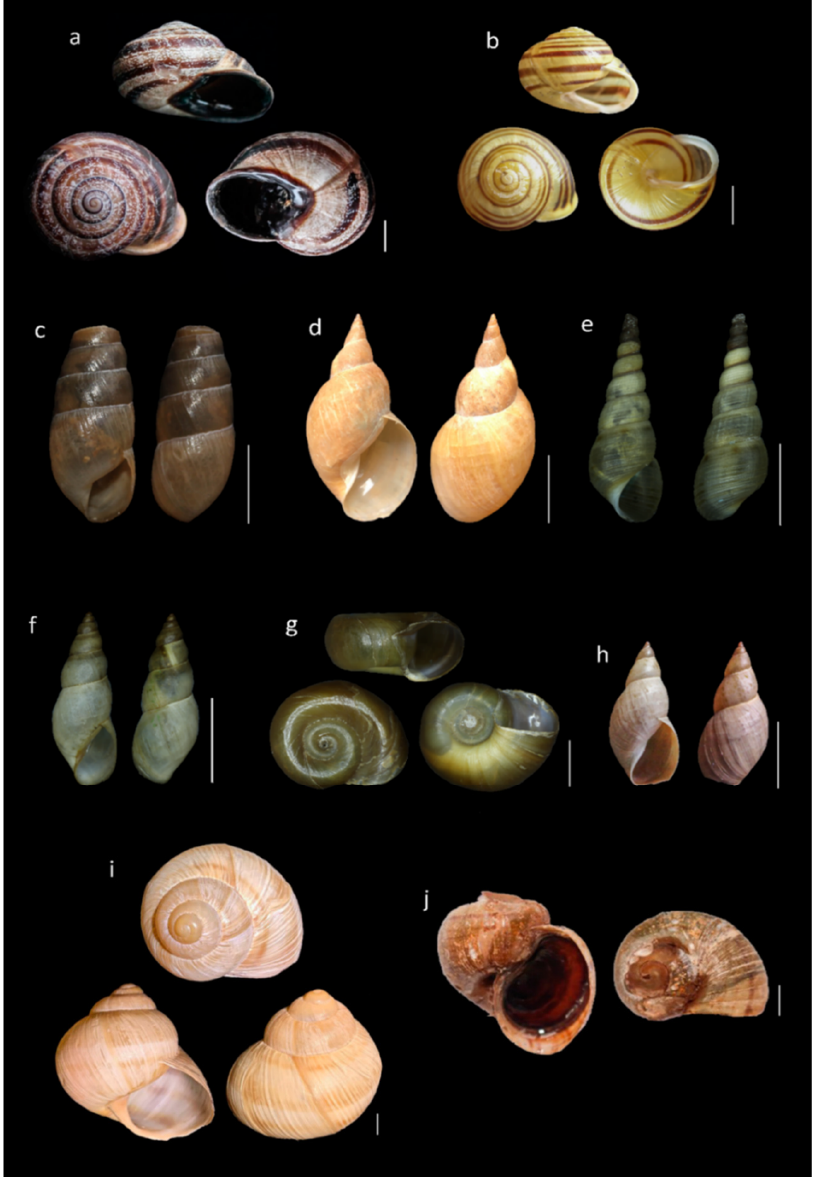
Figure 2. New species records for the Asturian malacofauna. ( a ) Otala lactea (La Corredoria-Oviedo), ( b ) Cepaea hortensis (Grandiella, Riosa), ( c ) Rumina decollata (dune system of San Juan de Nieva-Avilés), ( d ) Lymnaea stagnalis (Villanueva de Oscos pond), ( e ) Melanoides tuberculata (Nora River-Oviedo), ( f ) Omphiscola glabra (temporary pond in Avilés), ( g ) Planorbella duryi (Nalón River-El Entrego, San Martín del Rey Aurelio), ( h ) Stagnicola cf. palustris (spring in Lugones-Siero), ( i ) Helix pomatia (Isabel la Católica park-Gijón), ( j ) Pomacea cf. maculata (San Andrés de los Tacones reservoir-Gijón). All scale bars 1 cm.